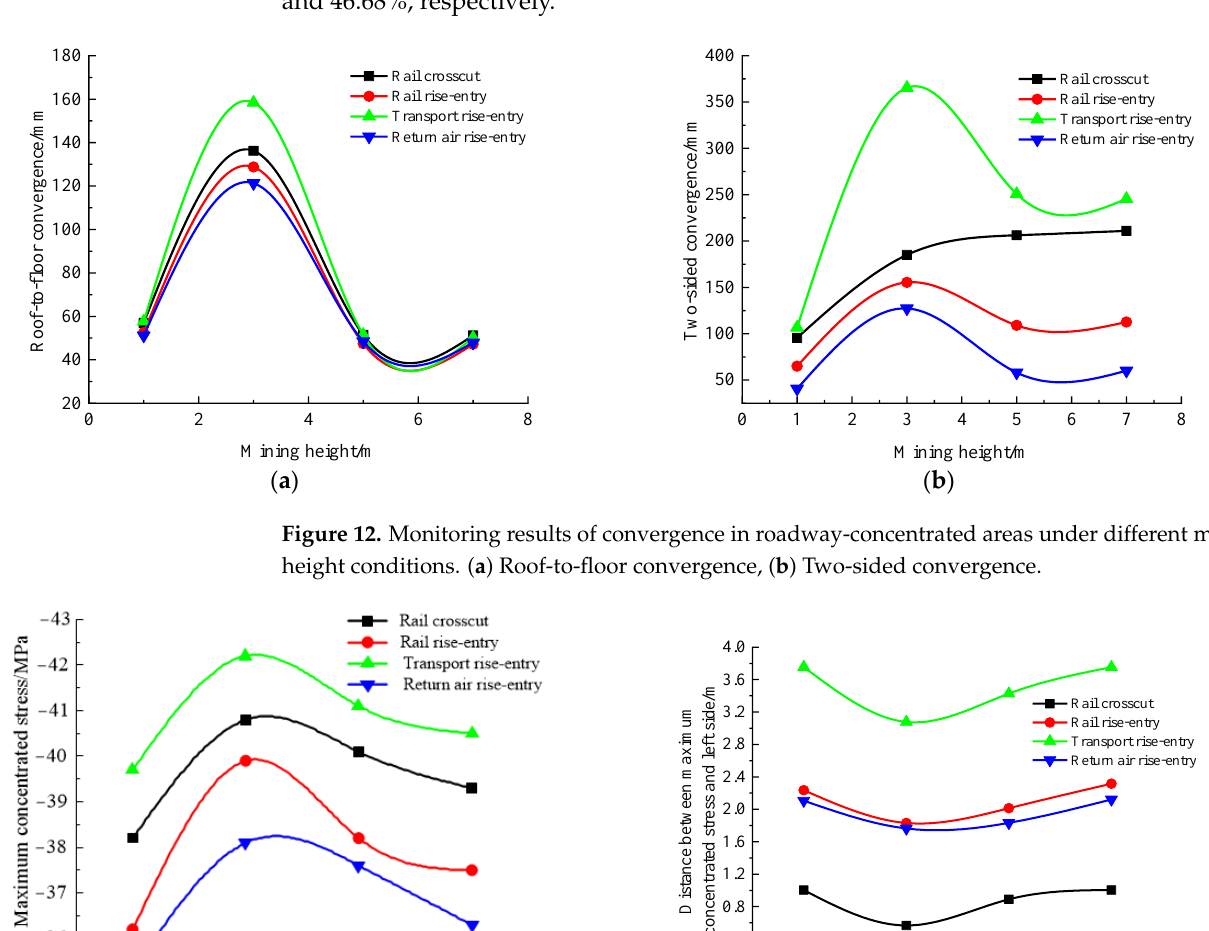
( b ) Figure 14. Monitoring results of convergence in roadway-concentrated areas under different sizes of rise-entry barrier coal pillar conditions. ( a ) Roof-to-floor convergence, ( b ) Two-sided conver- gence. It can be seen from Figure 14 that the influence of the size of the rise-entry barrier coal pillar on the roof-to-floor convergence in the roadway-concentrated areas under the